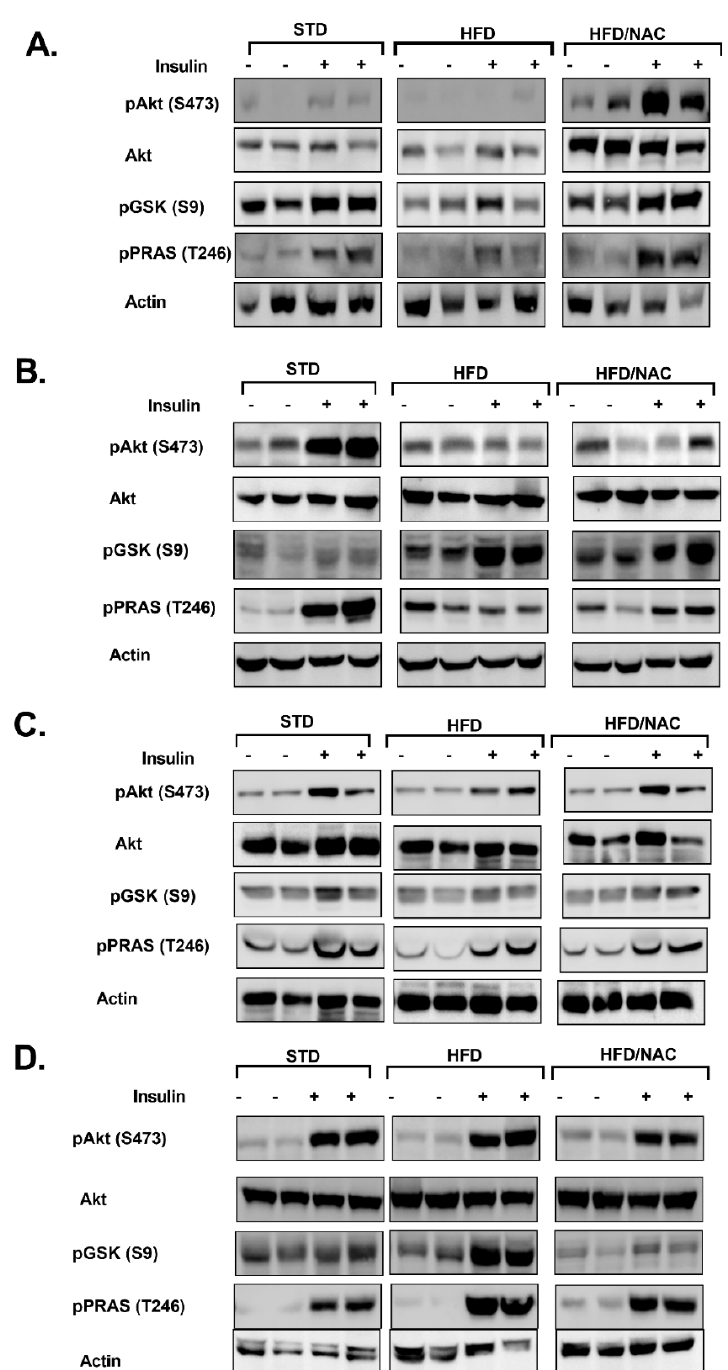
Figure 3. NAC improved the transmission of insulin signaling in HFD-fed offspring of NAC-treated male mice. NAC was given to females during pregnancy and lactation. HFD was given to offspring from the age of 6 weeks. Soleus muscle and liver of male ( A , B , respectively) and soleus muscle and liver of female ( C , D , respectively) offspring were removed at the age of 16 weeks as described in the Methods ( n = 5). Western blot analysis was performed on protein lysates of muscle and liver using specific antibodies. C/STD: STD-fed offspring of control mice, C/HFD: HFD-fed offspring of control mice, NAC/HFD: HFD-fed offspring of NAC-treated mice.